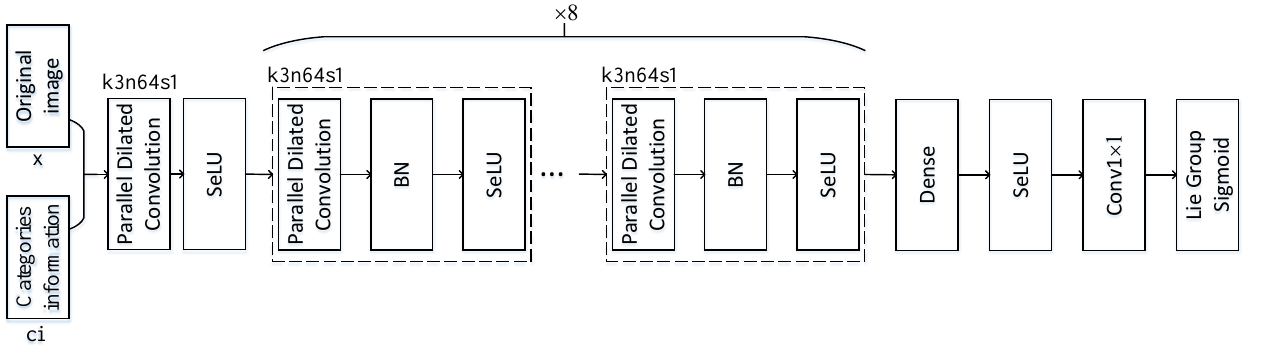
Figure 4. Network structure of the discriminator. K, n, and s indicate kernel size, number of feature maps, and stride,